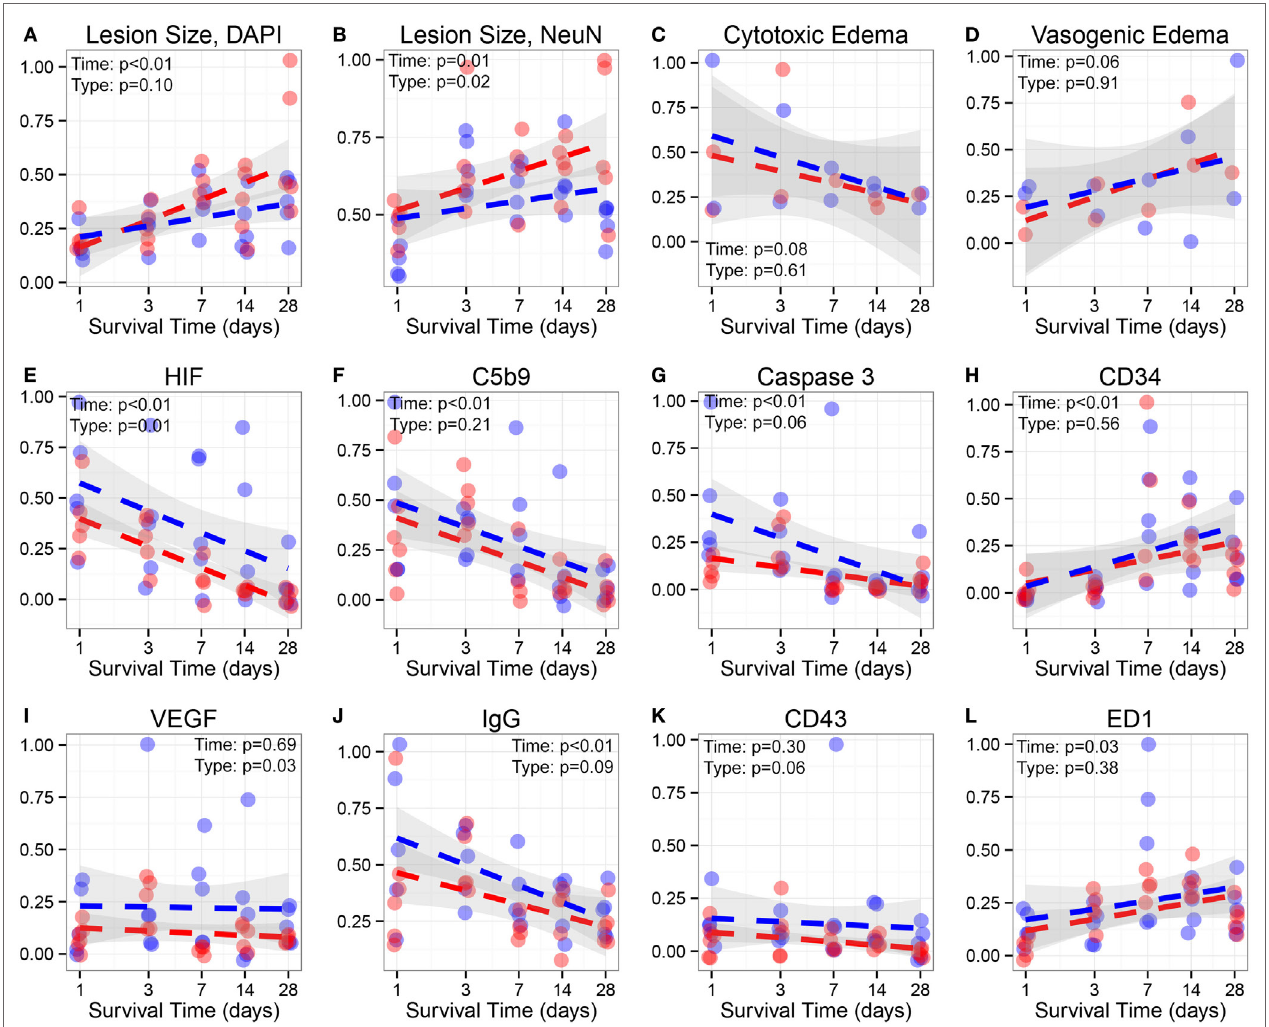
FigUre 6 | analyzes of lesion size, edema and immunofluorescence . Lesion size, edema, and immunofluorescence data analysis in hypoxic and normoxic rats: (a) , Lesion size using DAPI staining, (B) Lesion size using NeuN staining, (c) Cytotoxic edema on MRI, (D) Vasogenic edema on MRI, (e) HIF-1 α (HIF), (F) C5b-9, (g) Activated caspase-3, (h) CD34, (i) VEGF, (J) IgG, (K) CD43, and (l) ED-1 immunofluorescence intensity. Y -axis represent relative intensity. X -axis represents days after injury (log). Blue dots indicate normoxic while red dots represent hypoxic rats; dotted lines delineate regression lines. The gray area surrounding each line is the 95% confidence interval. Lesion area using DAPI and NeuN, HIF, C5b-9, Caspase-3, CD34, IgG, and ED1 changed significantly over time. Lesion Size, NeuN ( p = 0.02), HIF ( p = 0.01), and VEGF ( p = 0.03) are significantly different between normoxic/hypoxic